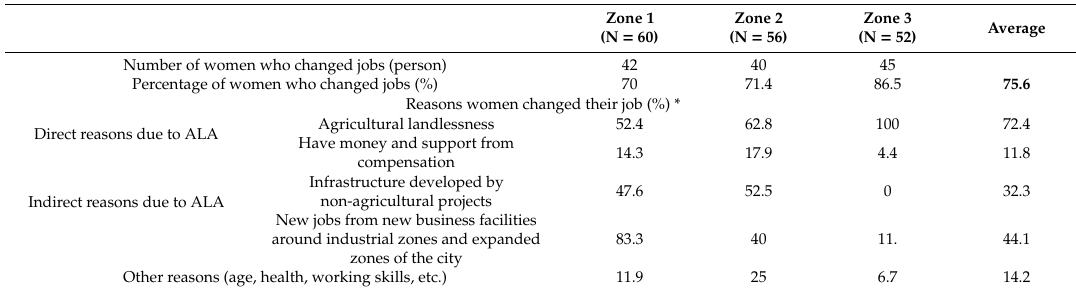
Table 4. Reasons for job changes of